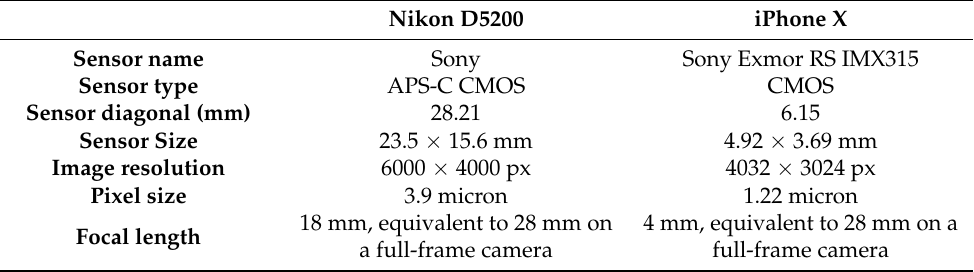
Table 3. Features of the cameras used.